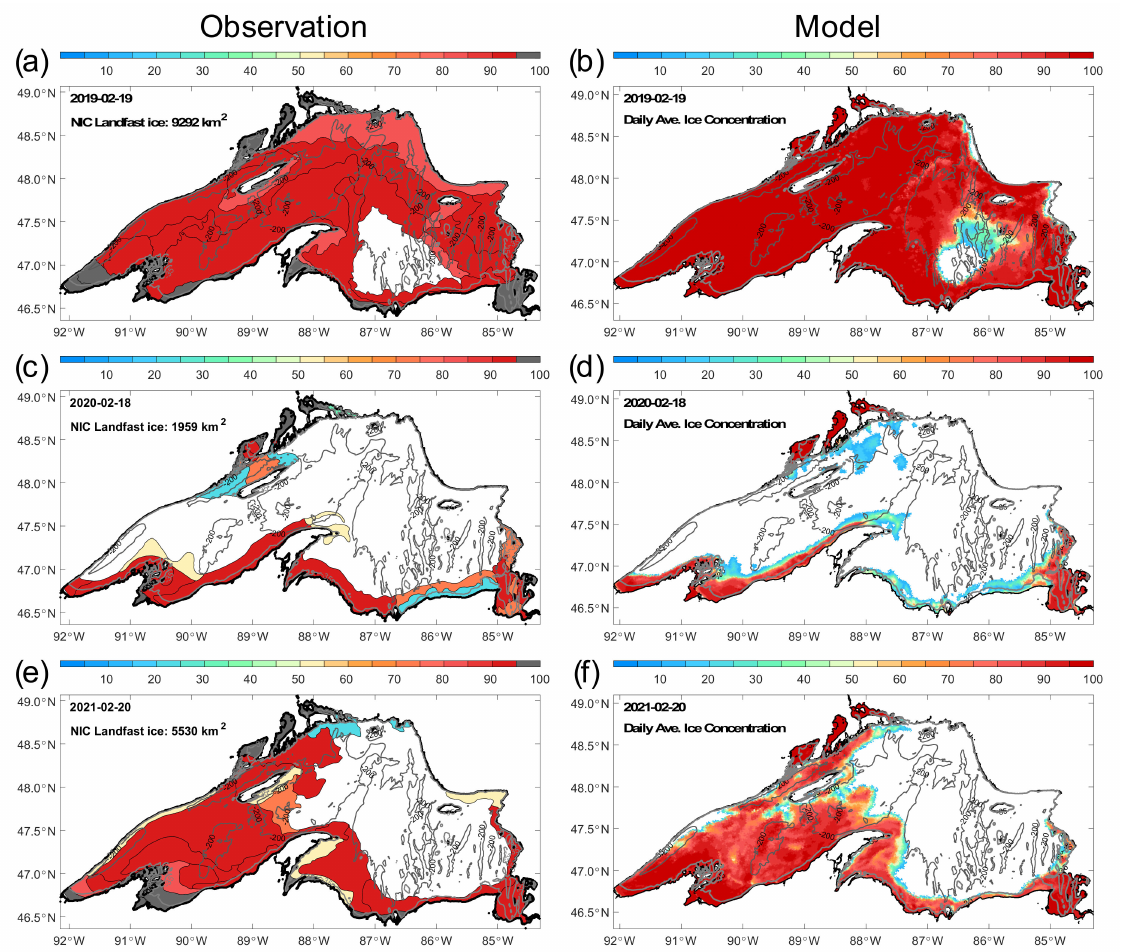
Figure 3. Snapshots of ice concentration from NIC observations ( a , c , e ) and model outputs ( b , d , f ) before the maximum ice cover of each year. Landfast ice from the NIC is marked as gray. The first and the second gray contours indicate the 35 m and the 200 m isobath,